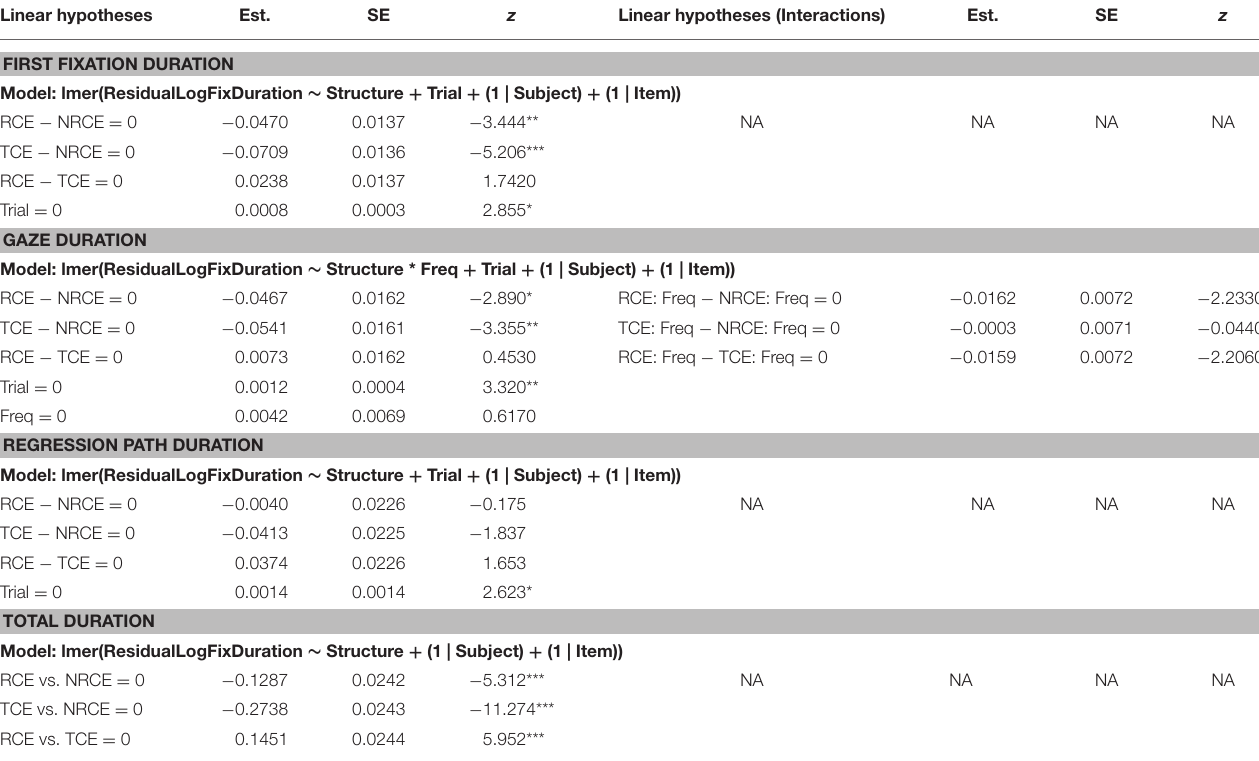
TABLE 5 | Experiment 1 R02 (PP): Simultaneous tests for general linear hypotheses for linear effects models fitted to log-transformed and residualized fixation durations. Linear